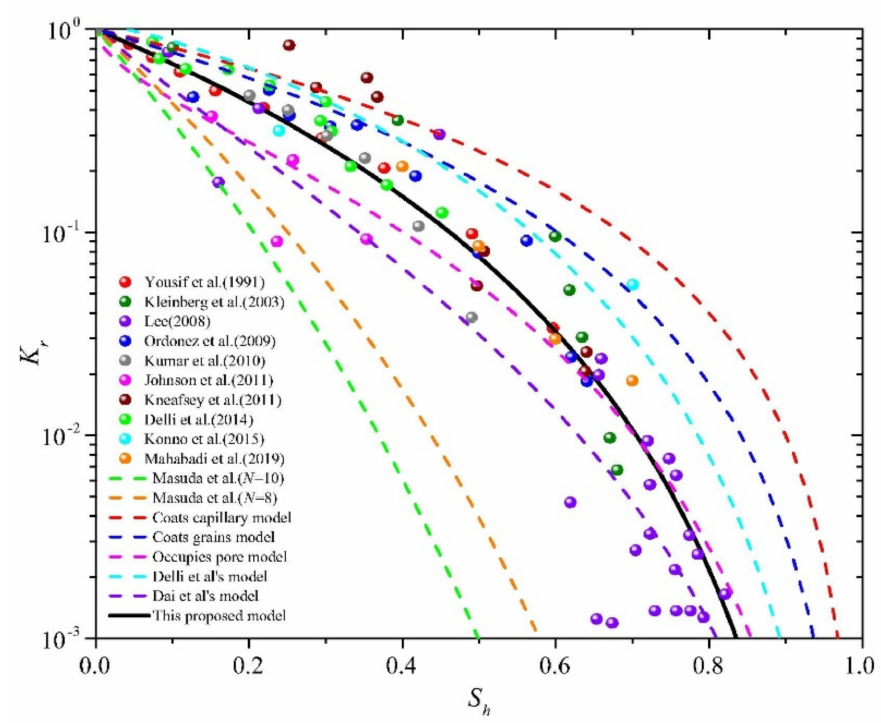
Figure 21. Relationships between relative water permeability and hydrate saturation from reported experiment data [23,24,27,82,89,94,111–114] and analytical prediction results [23,24,40,42] reprinted from [62] with permission from